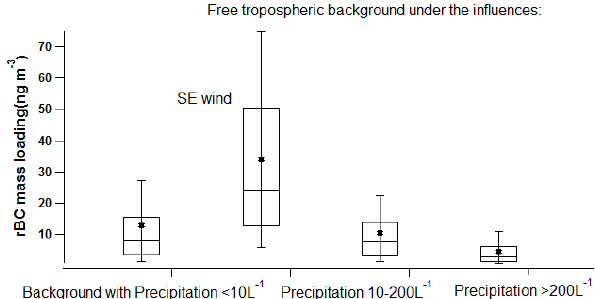
Fig. 11. Statistical analysis of the rBC mass loading at this site: The free tropospheric background contributed by ground sources delivered to the JFJ during periods of SE wind ad the sink governed by precipitation. The upper and lower edges of the box denote the 25% and 75% percentiles respectively. The lines in the middle of box and cross markers indicate the median and average values, with error bars explaining the 10% and 90%